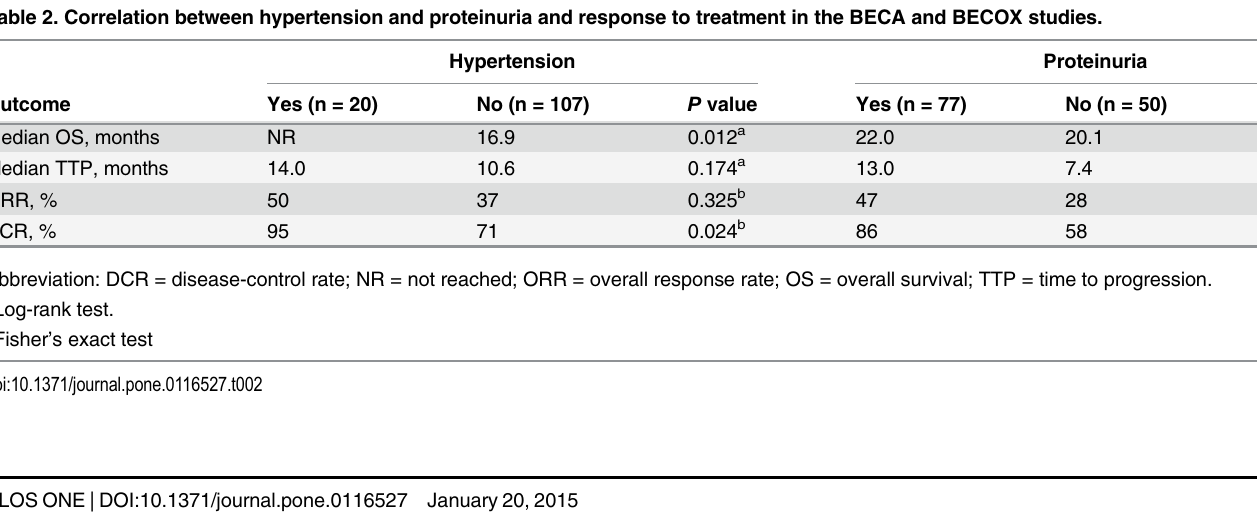
Table 2. Correlation between hypertension and proteinuria and response to treatment in the BECA and BECOX studies. Hypertension Proteinuria Outcome